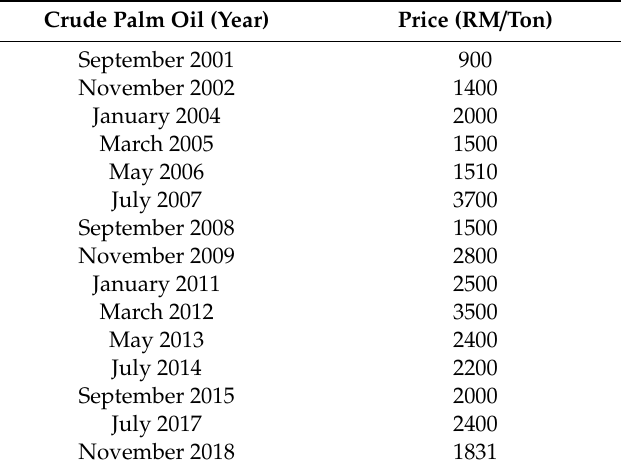
Table 4. Crude palm oil statistics